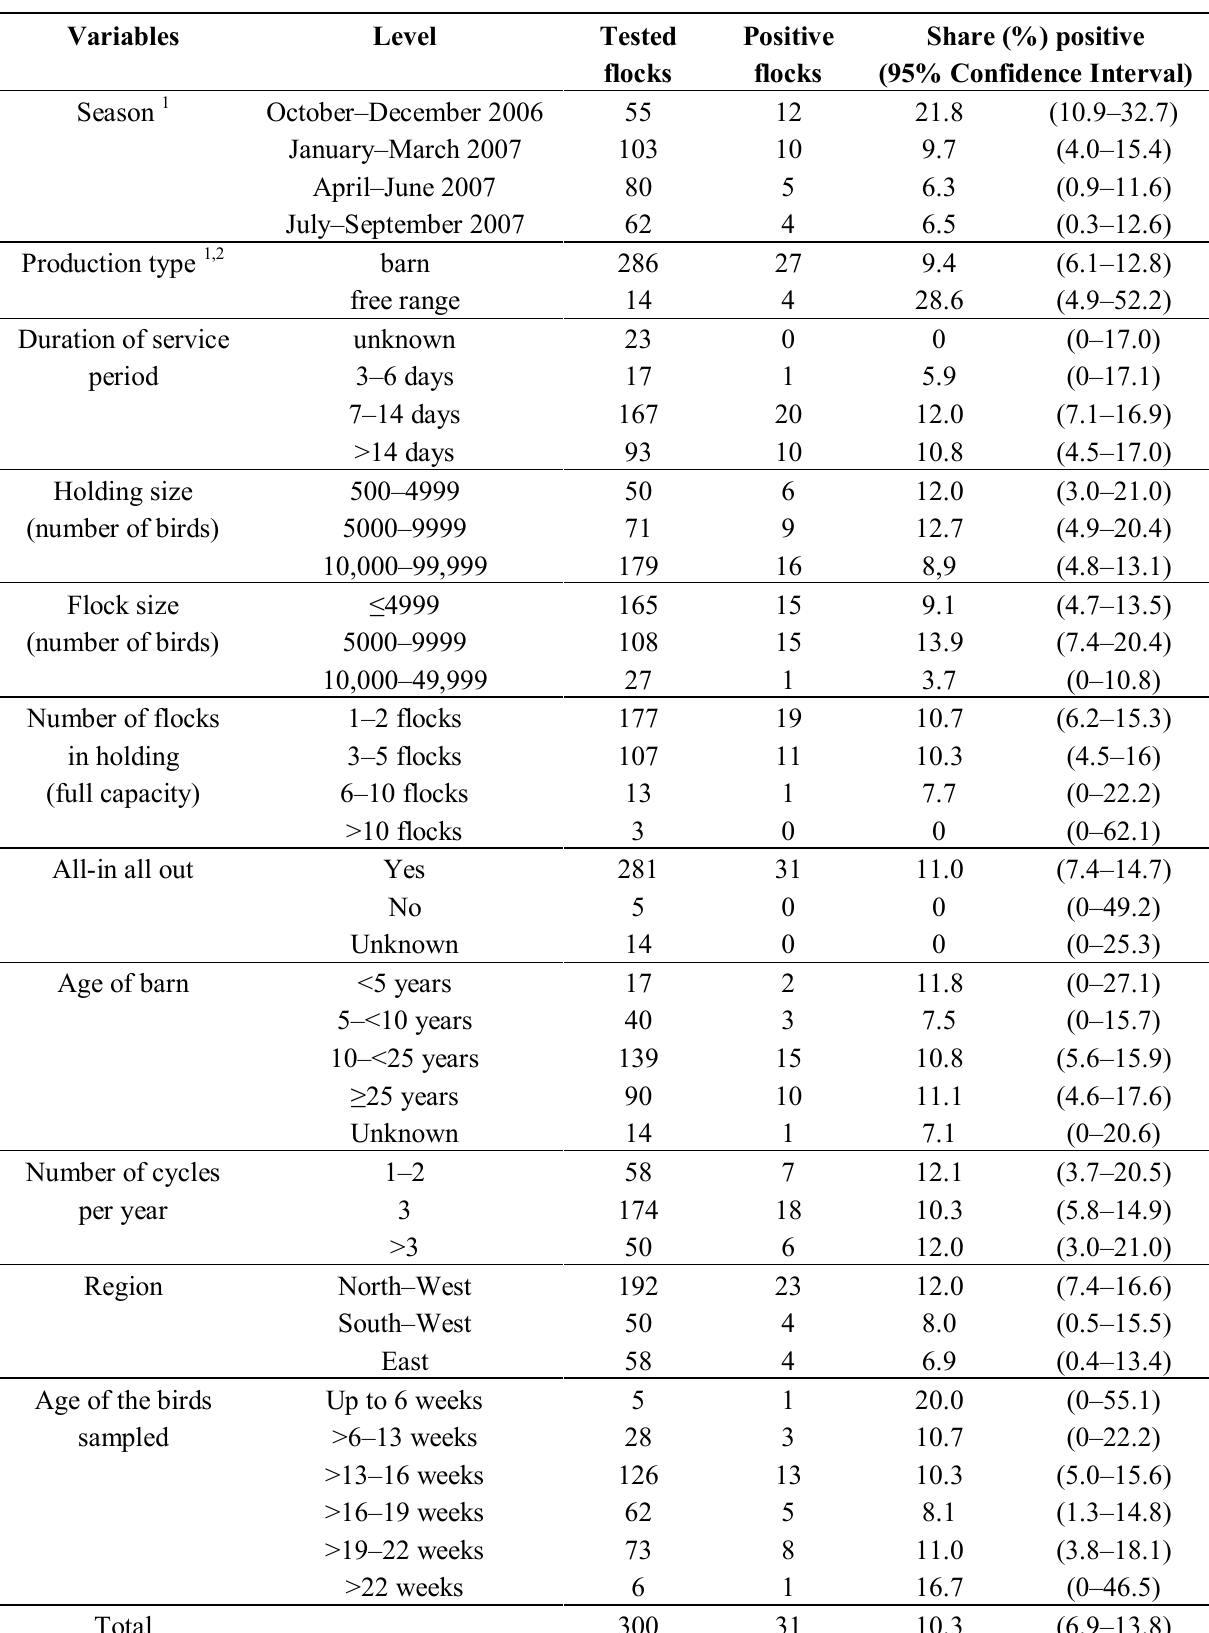
Table 5. Salmonella prevalence in turkey fattening flocks. Factors included in univariate